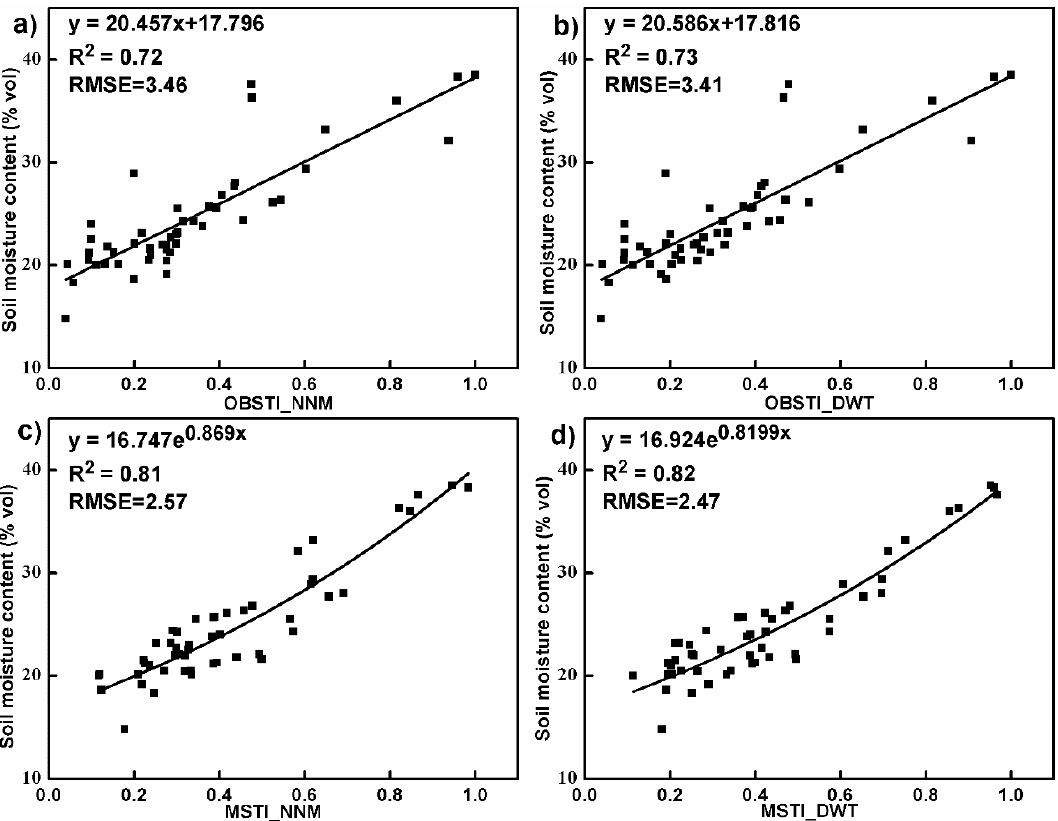
Figure 13. The selected models for accounting for the relationship of soil moisture content (SMC) with soil and bare soil thermal inertia (STI): ( a ) The linear model of SMC with the original-model-derived bare STI at the 15 m resampling spatial resolution (OBSTI_NNM); ( b ) The linear model of SMC with the original-model-derived bare STI at the 15 m fusion spatial resolution (OBSTI_DWT); ( c ) The exponential model of SMC with the modified-model-derived STI at the 15 m resampling spatial resolution (MSTI_NNM); and ( d ) The exponential model of SMC with the modified-model-derived STI at the 15 m fusion spatial resolution (MSTI_DWT). The R 2 and RMSE (J · m − 2 · s − 1/2 · K (cid:2879)(cid:2869) ) are the coefficient of determination and root mean square error between the estimates and observations of SMC.